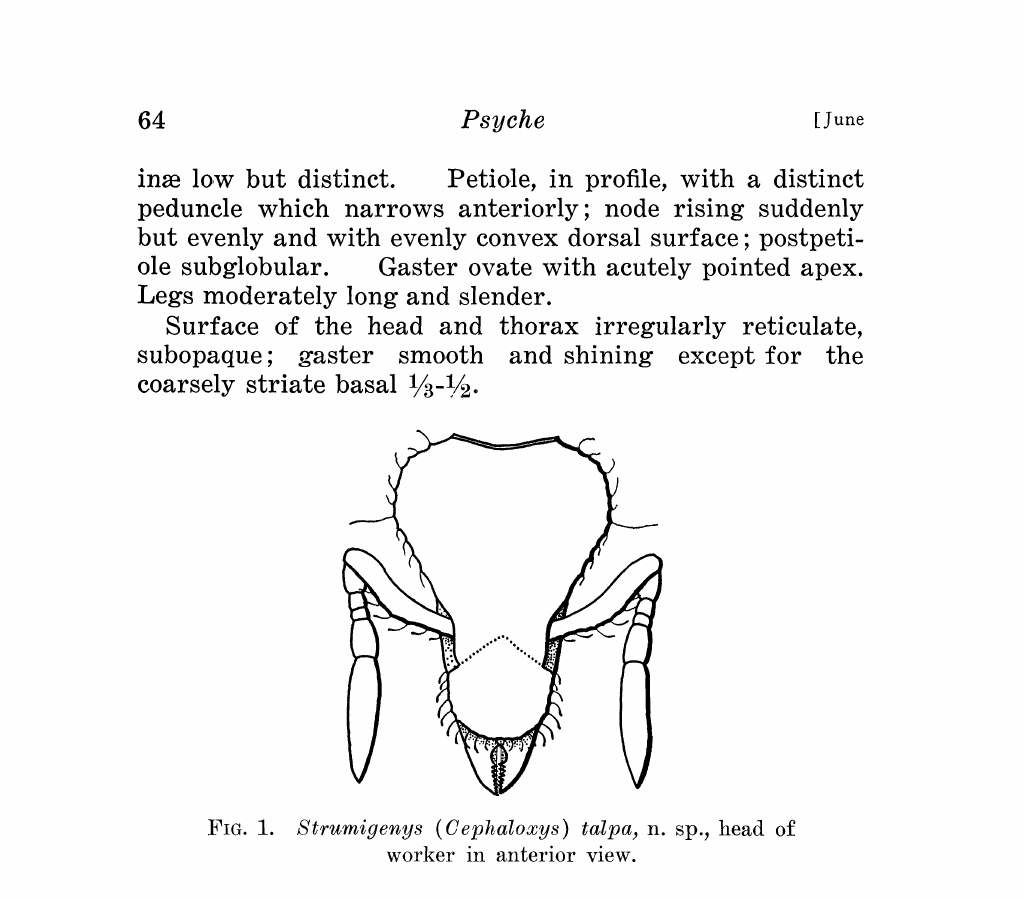
FIG. 1. Strumigenys (Cephaloxys) talpa, n. sp., head of worker in anterior